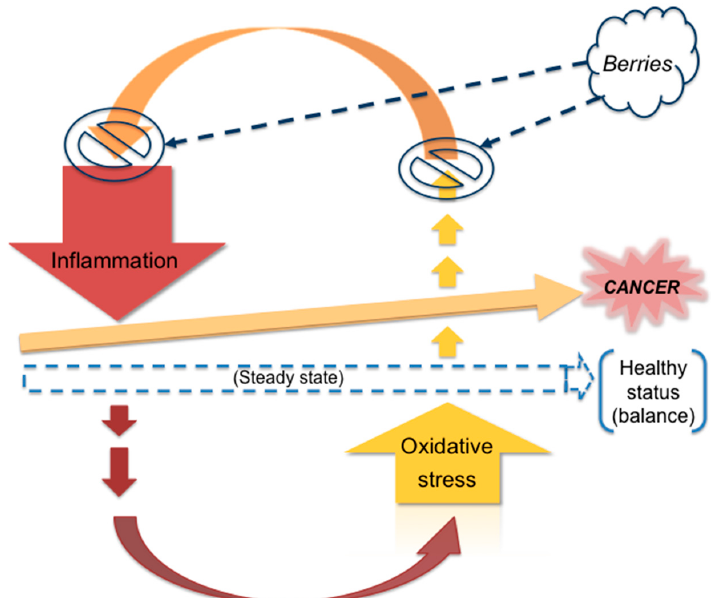
Figure 3. Conceptual schematic representation depicting the contribution of oxidative stress and inflammation in the deregulation/disturbance of homeostatic balance in a cell, thus leading to cancer. Berries by means of their numerous constituents (synergistic action) can interrupt this vicious cycle, thereby extending protective effects against cancer.